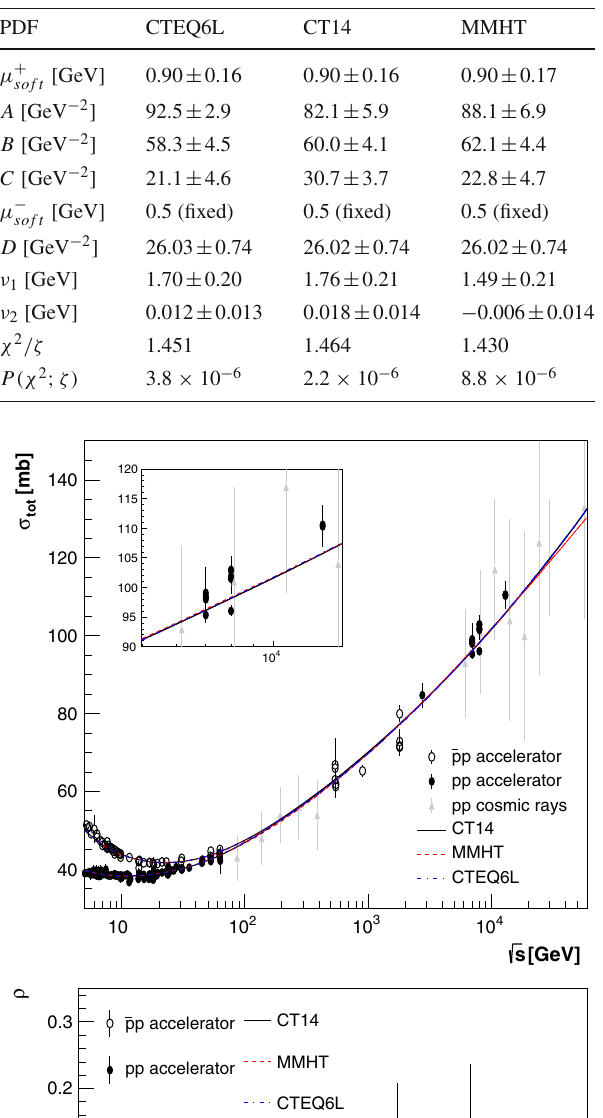
Fig. 6 Global 1 σ -fit to σ pp √